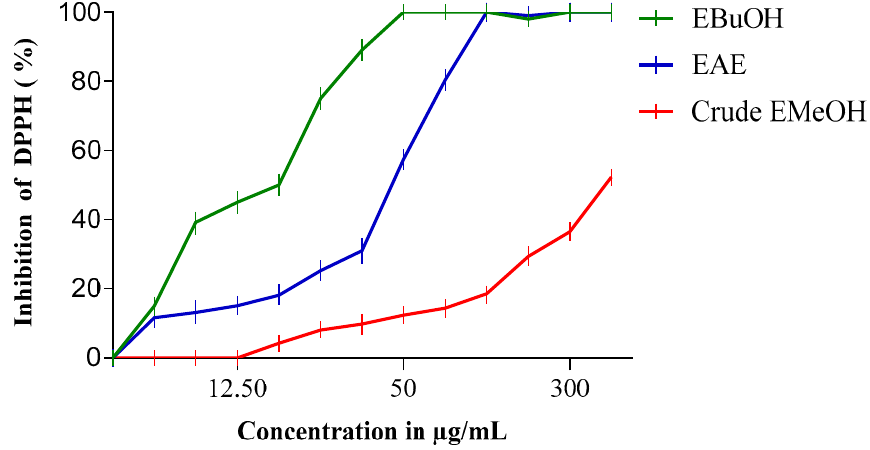
Figure 2. Inhibition of DPPH (%) by n-Butanol (EBuOH), ethyl acetate (EAE), and crude methanol extract (Crude EMeOH) fractions of L. sativum Seeds.